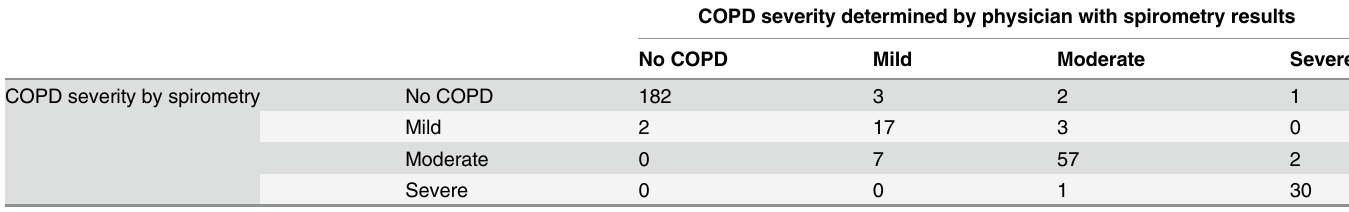
COPD severity determined by physician with spirometry results Moderate Severe